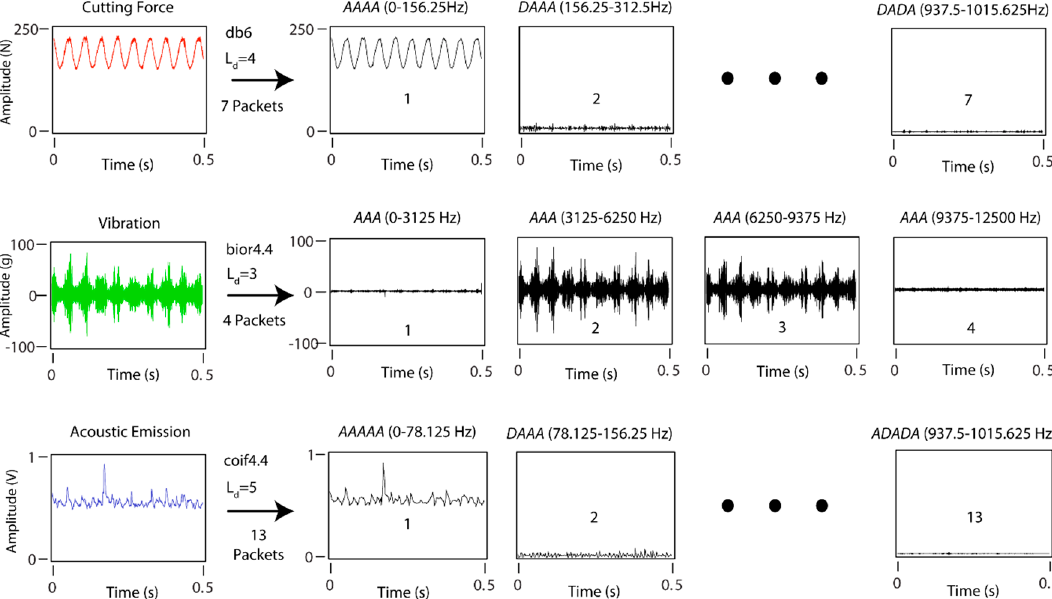
Figure 13. WPT method applied to cutting force, vibration, and acoustic emission signals.